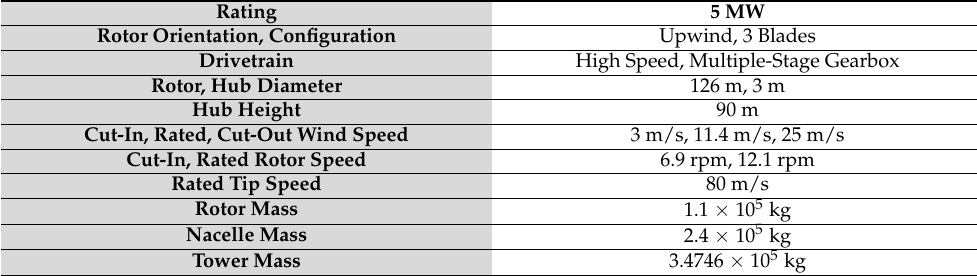
Table 2. Properties selected for the NREL 5-MW baseline wind turbine (source from: [14]).